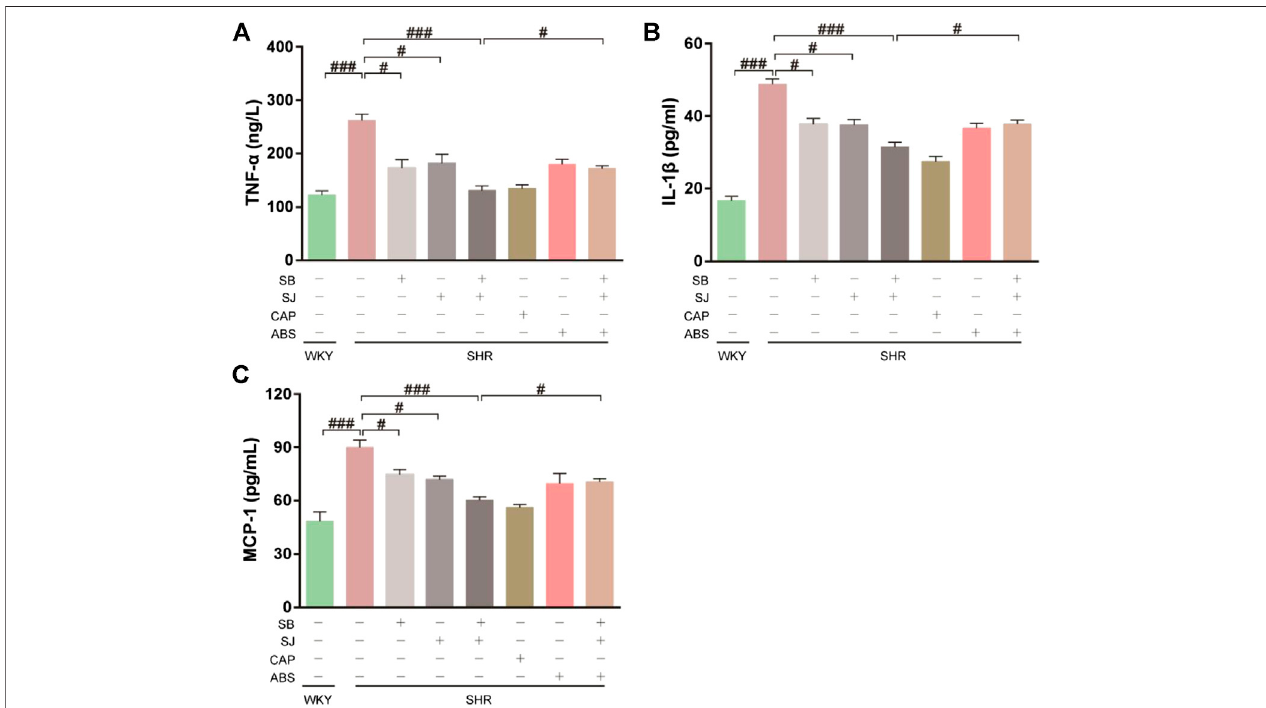
FIGURE 7 | Inhibition of serum in fl ammation by the combination of SB and SJ in SHR. (A – C) In fl ammatory markers, including TNF- α , IL-1 β , and MCP-1, were assessed. Data are presented as the mean ± SD. ### p < 0.001. ## p < 0.01. # p < 0.05.